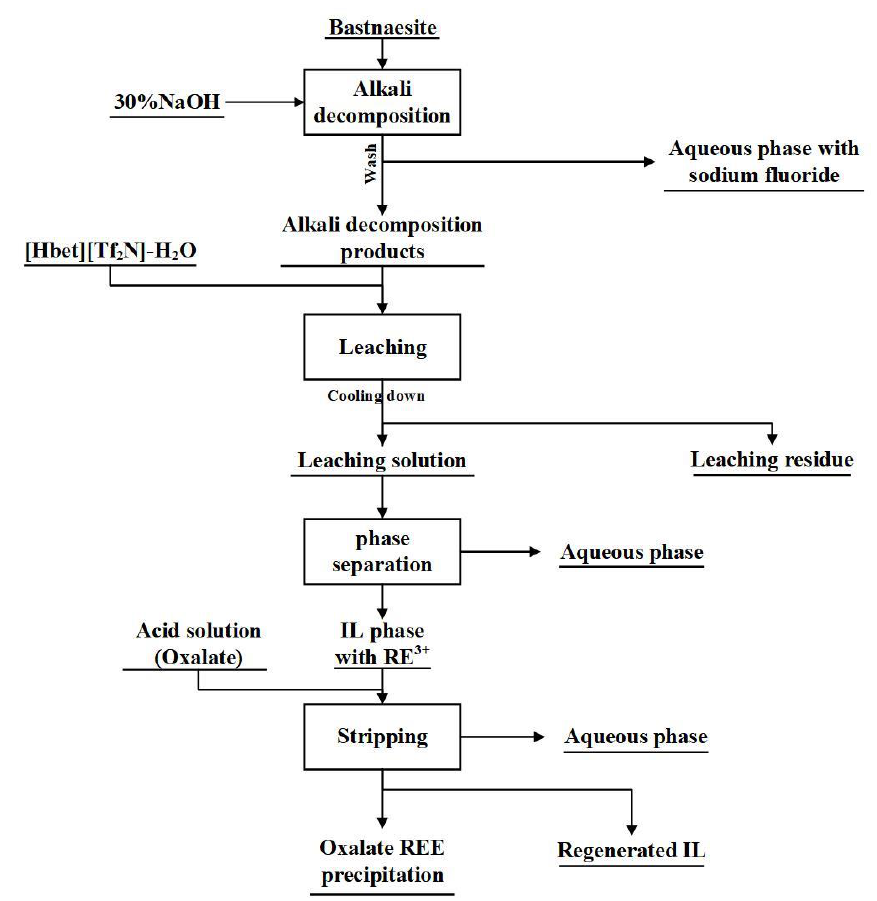
Figure 2. The process flow of the leaching and stripping REE.